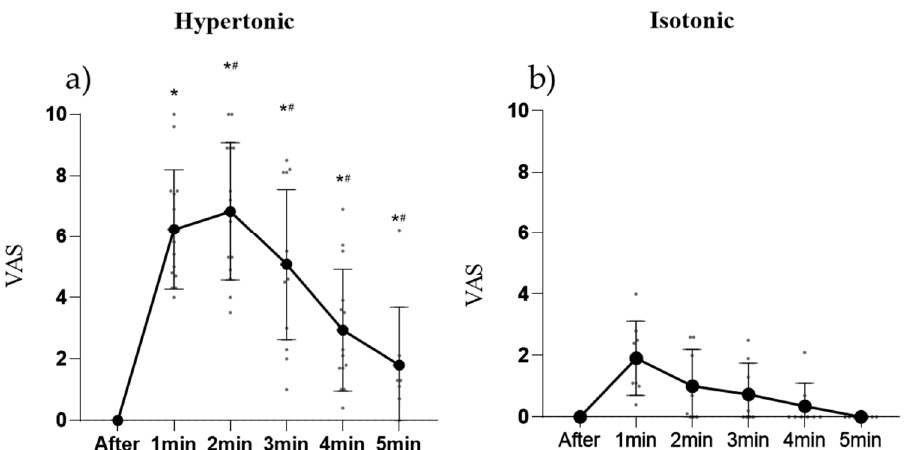
Figure 1. Pain score obtained from a visual analog scale, where “0” means no pain and 10 “maximal tolerable pain”. ( a ) Pain curve during hypertonic saline injection (pain induction). ( b ) Pain curve during isotonic saline injection (placebo). * Significant difference from baseline ( p < 0.05), # Significant difference from the previous minute ( p < 0.05).